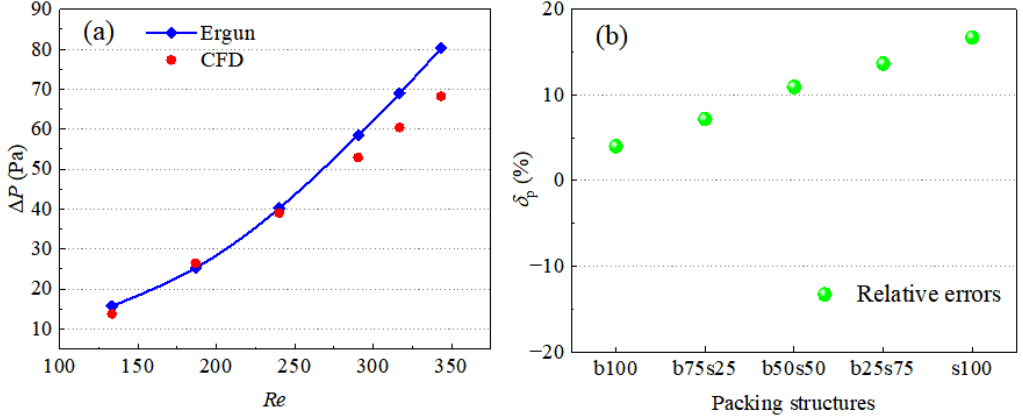
Figure 10. ( a ) Comparison of pressure drop between the simulated results based on the DEM-CFD model and the data calculated by the Ergun equation; ( b ) relative errors in different packed beds at u inlet = 0.8 m/s.